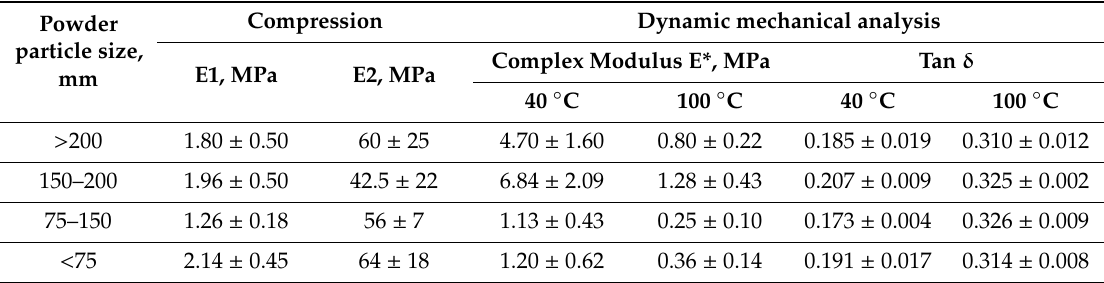
Table 1 summarizes data on the apparent elastic moduli E 1 , E 2 , complex modulus, and tan δ at ◦ 40 and 100 C for the compressive test and the Young’ modulus for tensile and bending experiments. Table 1. The static and dynamic mechanical properties of porous open-cell